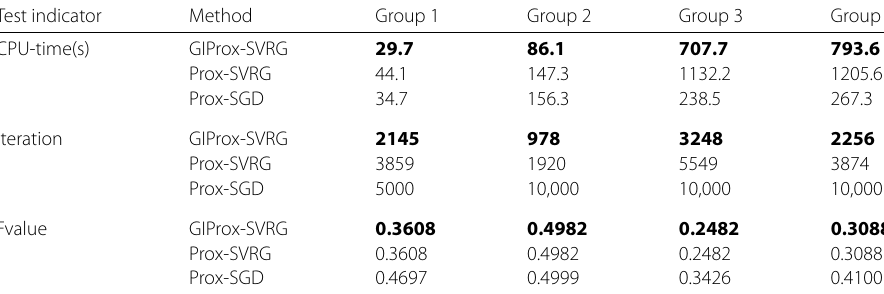
Table 3 The performance of different algorithms for sigmod regression Test